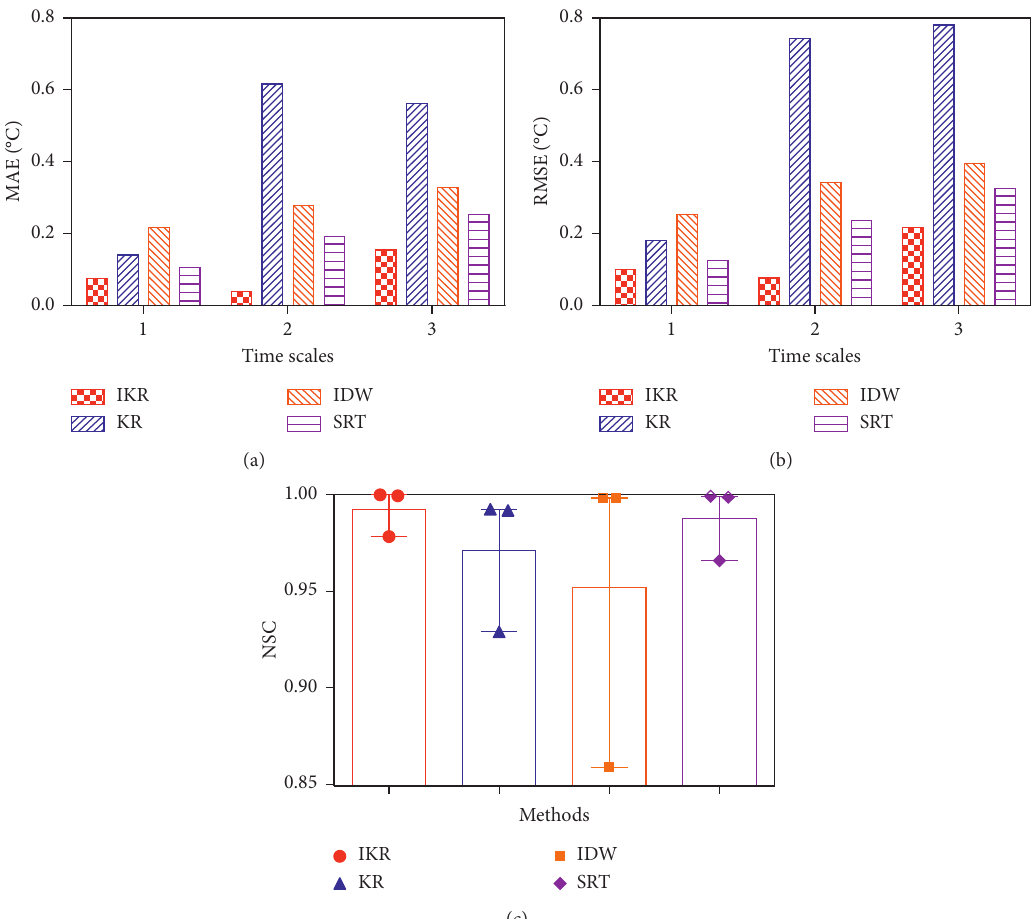
Figure 5: Comparison of the performance indicators of the four methods on different time scales for Jiangsu single-station kernel re- gression: (a) MAE; (b) RMSE; (c)